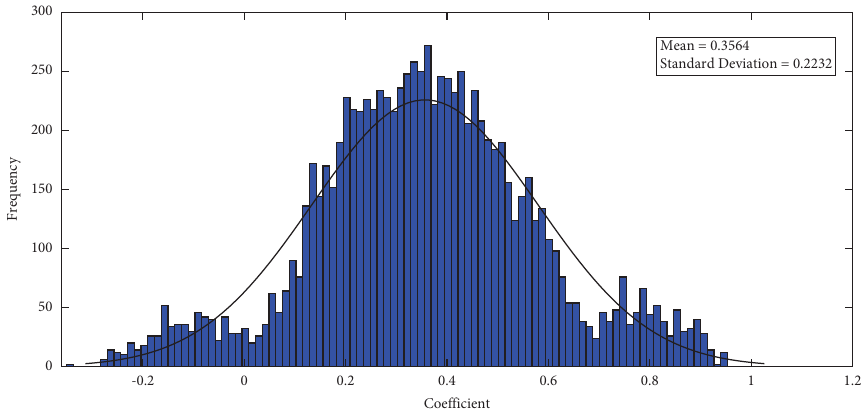
Figure 2: Distribution histogram of the correlation